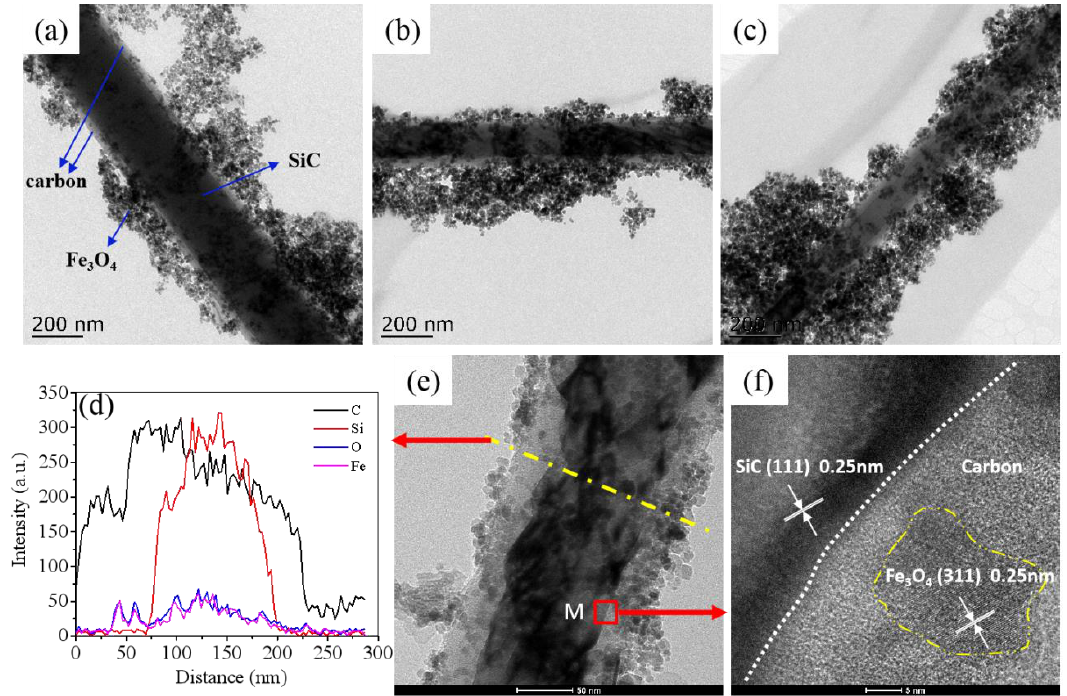
Figure 3. TEM images of all samples investigated: ( a ) SCF1-1; ( b ) SCF2-2; ( c ) SCF4-4; Line scanning profiles ( d ) of C, Si, O, and Fe recorded along the line labeled in HRTEM image ( e ) of SCF1-1; HRTEM image ( f ) derived from the area M in ( e ).